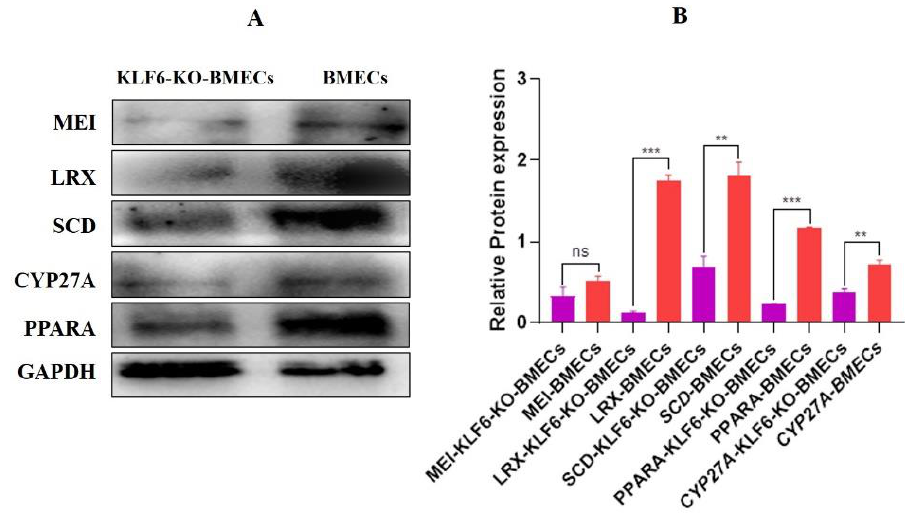
Figure 15. Protein expression of lipid metabolism-related genes ( A , B ) The relative protein expression Figure 16 of PPARA and their genes are associated with lipogenesis and cholesterol metabolism in the KLF6 - KO-BMECs and normal BMECs. ns = non-significant, ** p < 0.01, *** p < 0.001.